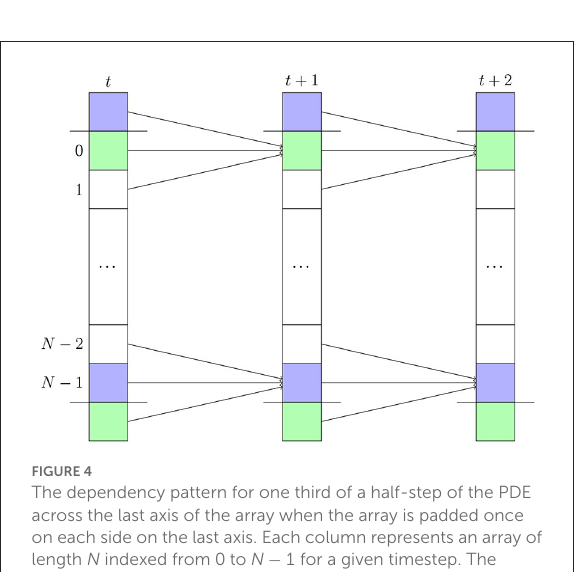
FIGURE4 The dependency pattern for one third of a half-step of the PDE across the last axis of the array when the array is padded once on each side on the last axis. Each column represents an array of length N indexed from 0 to N − 1 for a given timestep. The elements colored in the same color have the same value. The element at index i of the array at time t + 1 depends on the elements at indices i , i − 1, and i + 1 of the array at time t